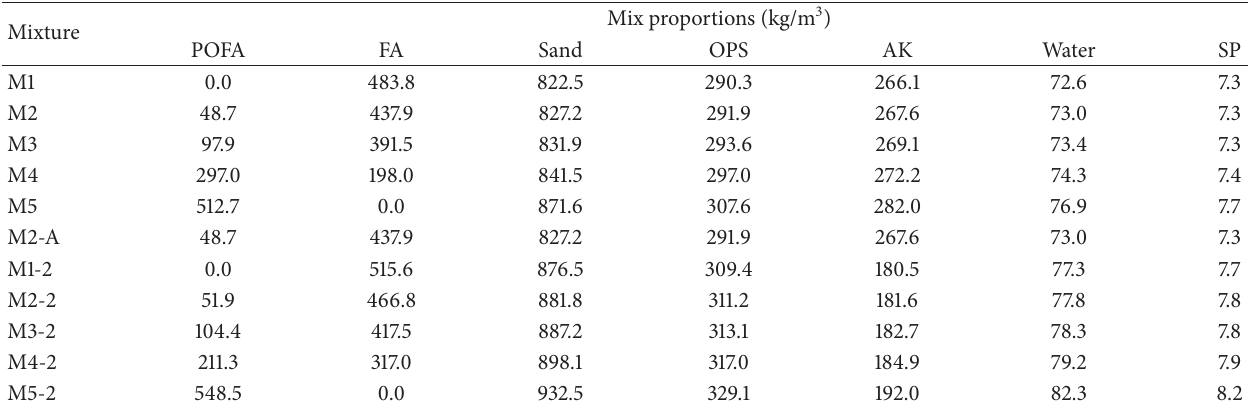
Table 4: Mixture proportions of the OPSGC.